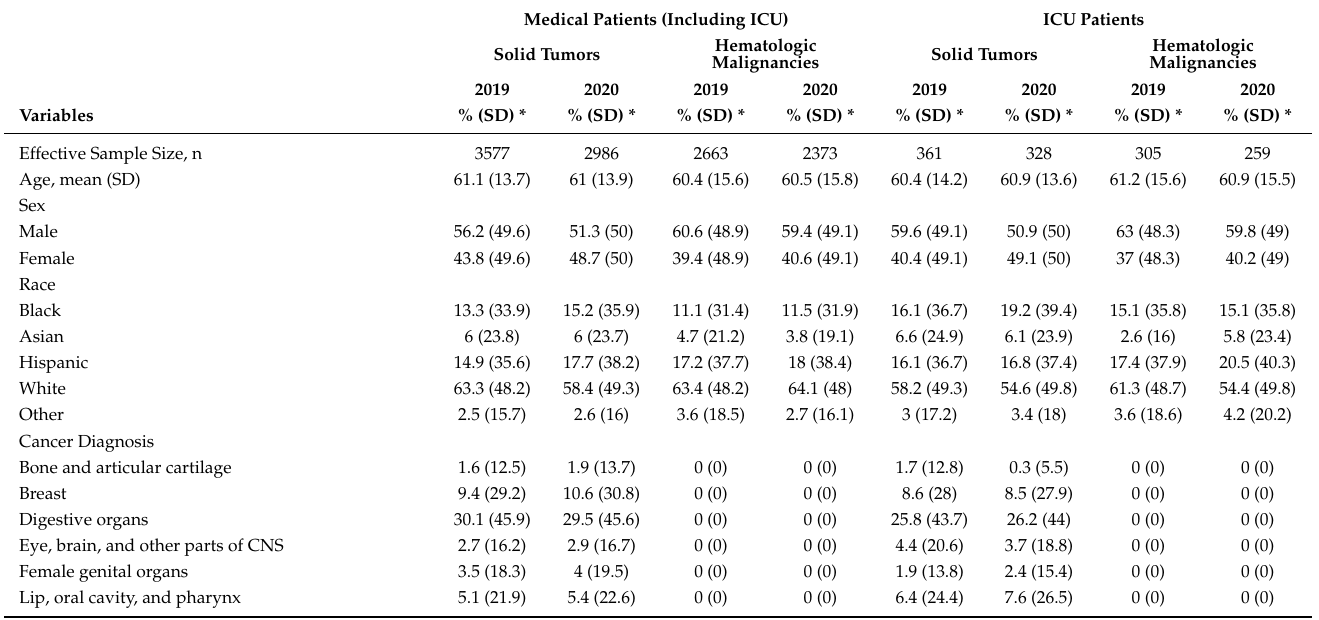
Table 1. Patient